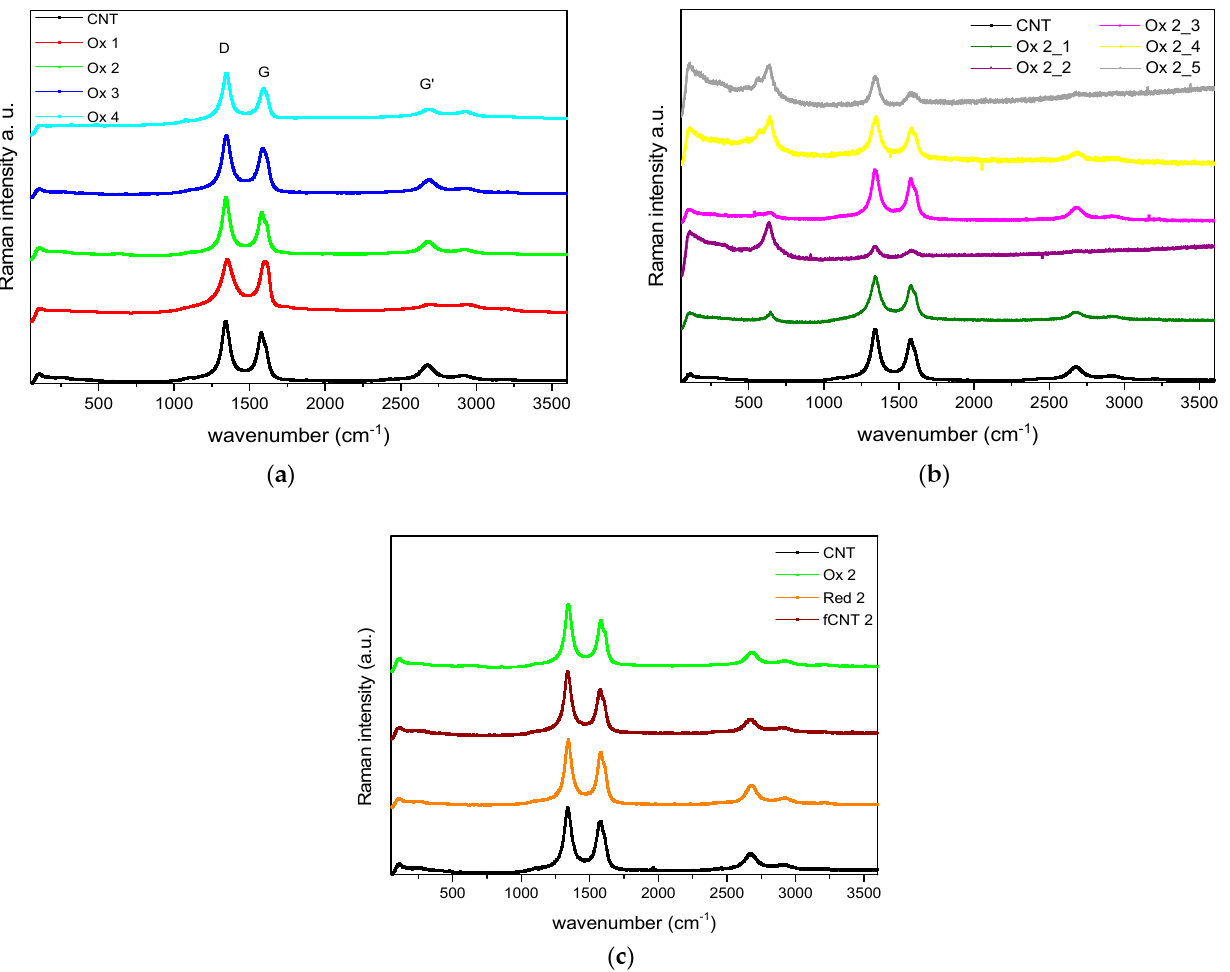
Figure 11. Raman-spectra of ( a ) oxidized, ( b ) reduced, and ( c ) functionalized CNTs. Table 3. Ratio of Raman-intensities I D /I G and aromatic cluster size.